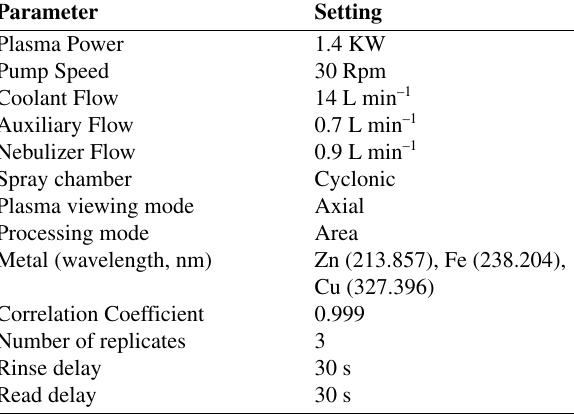
Table 1 . ICP-OES instrument parameter settings